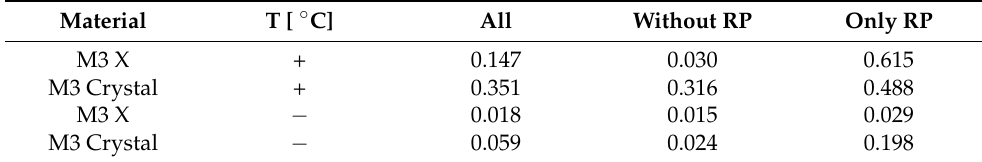
Table 6. Mean strain differences 1 × 10 − 3 (m/m) among the samples—all sensors.